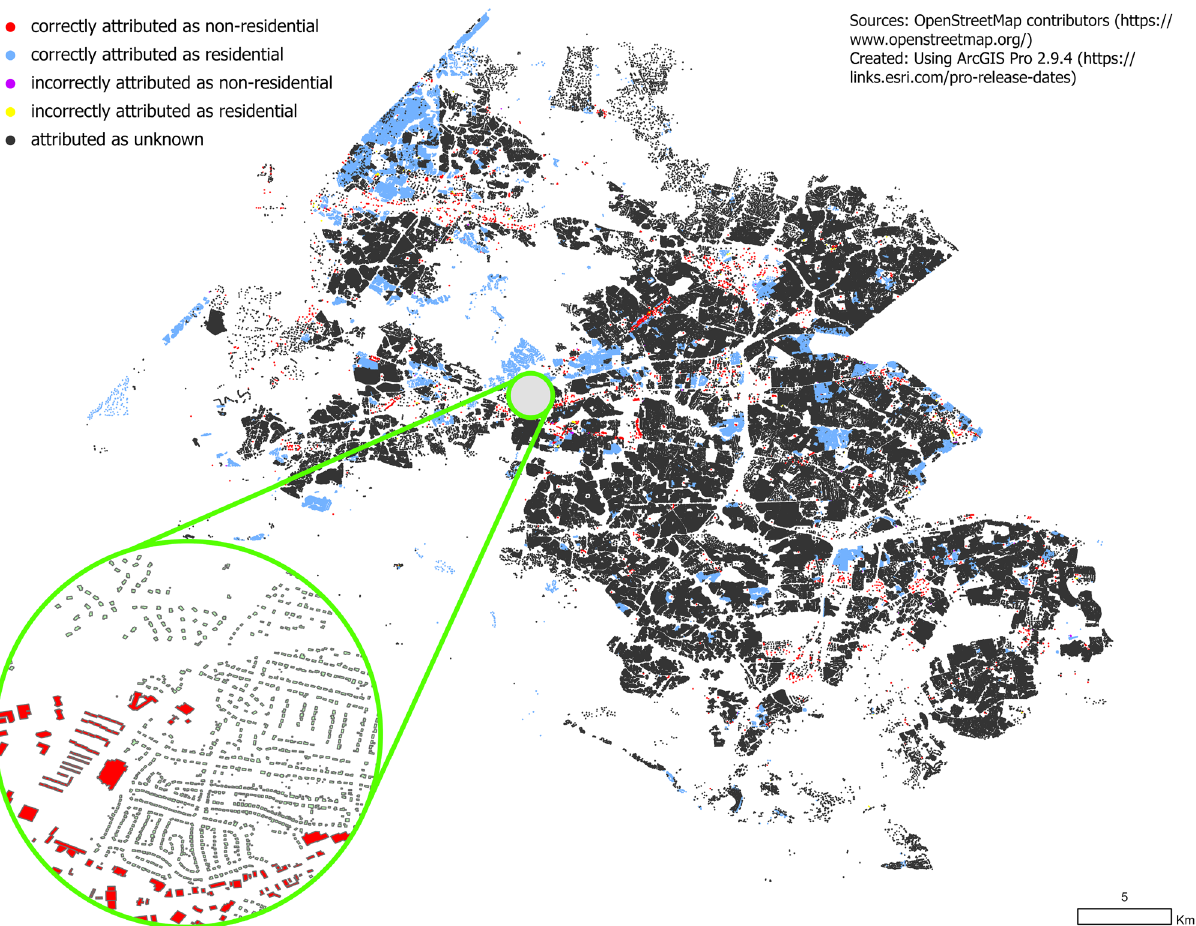
Figure 1. Residential and non-residential building types based on OpenStreetMap data for Fairfax County, USA. Most building types are unknown due to OSM not having explicit